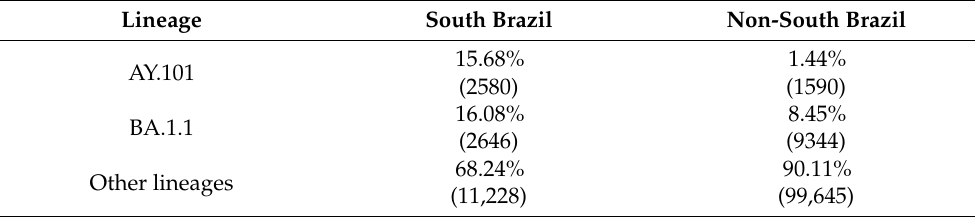
Table A6. Percentage of AY.101, BA.1.1, and other lineages between the South and the rest of Brazil.